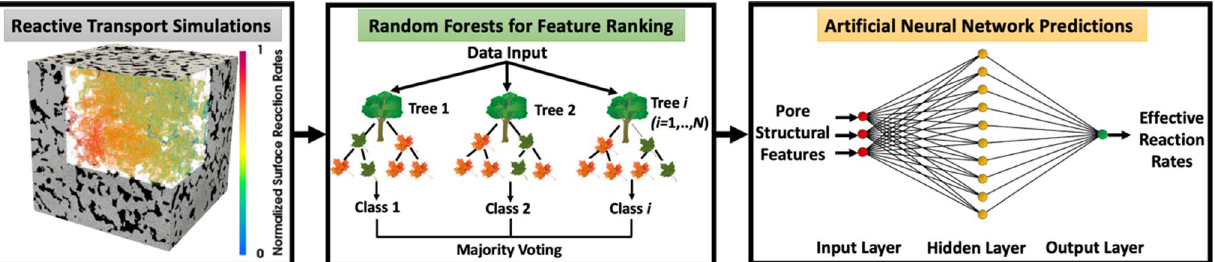
Figure 2. The schematic of the ML-based framework that combines 3D pore-scale reactive transport, Random Forests (RF), and Artificial Neural Network (ANN)